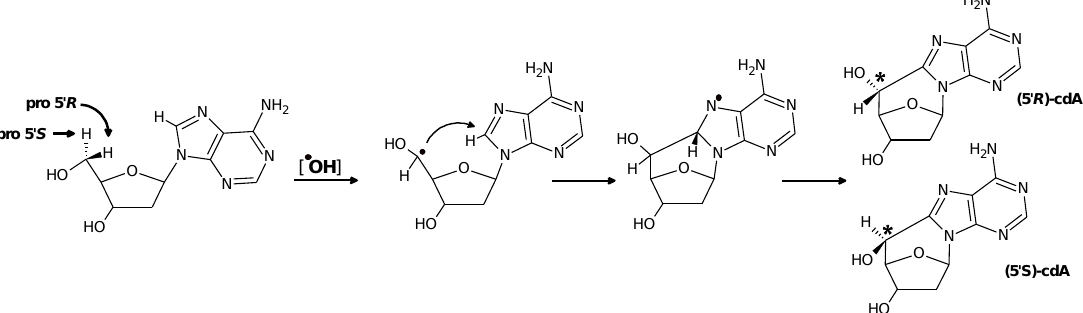
Figure 2. The possible reaction path of (5’ R ) and (5’ S ) 5’,8-cyclo-2’-deoxyadenosine formation [47].